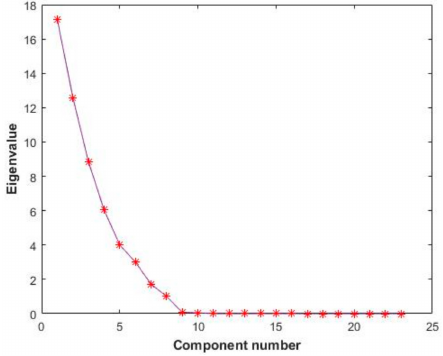
Figure 3. Determination of the number of uncorrelated components with Principal Component Analysis (PCA).